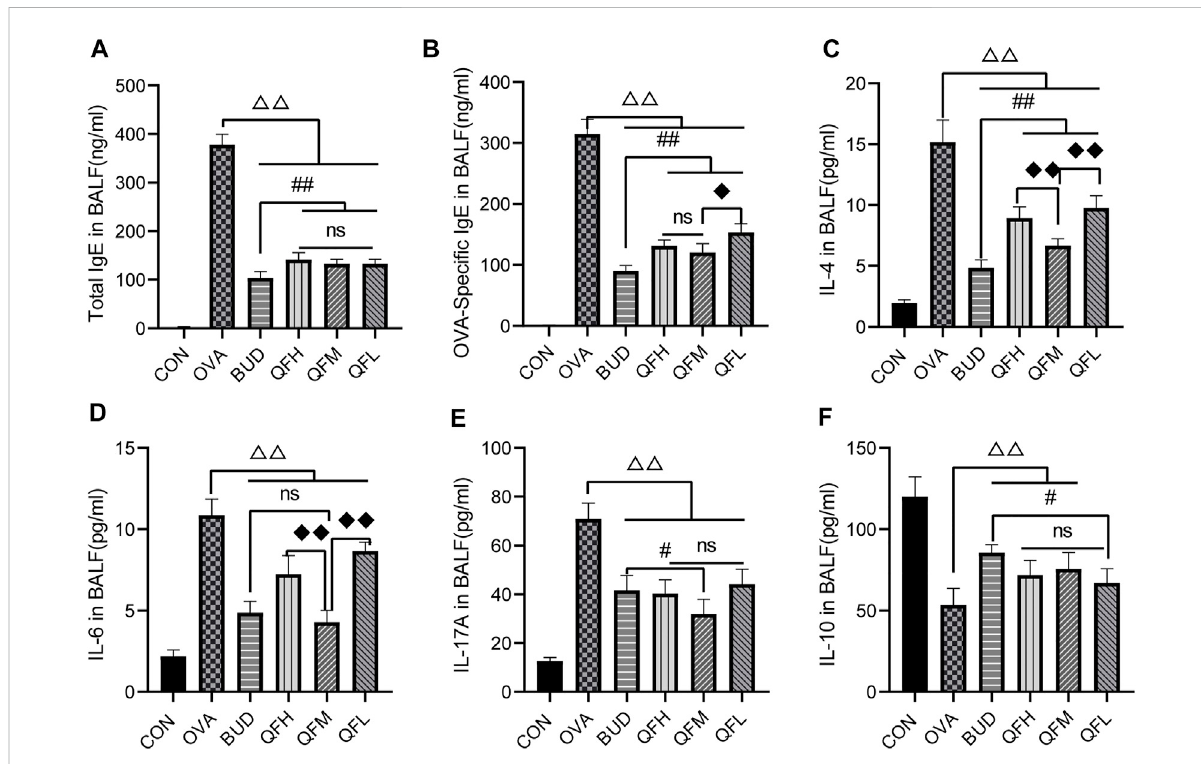
FIGURE 3 Effects of Qingfei oral liquid (QF) on IgE and in fl ammatory cytokines in bronchoalveolar lavage fl uid (BALF) of asthmatic mice. BALF samples from different groups were collected to detect the levels of (A) total IgE, (B) Ovalbumin (OVA)-speci fi c IgE, (C) IL-4, (D) IL-6, (E) IL-17A, and (F) IL-10 using ELISA. Data are expressed as mean ± standard deviation (SD) and were performed with one-way ANOVA followed by Tukey ’ s tests. n = 6, △ p ≤ 0.05vs.theOVAgroup, △△ p ≤ 0.01vs.theOVAgroup; # p ≤ 0.05vs.thebudesonide(BUD)group, ## p ≤ 0.01vs.theBUDgroup; ◆ p ≤ 0.05vs.the QFM group, ◆◆ p ≤ 0.01 vs. the QFM group; ns: no difference; line over bars indicates that all groups are